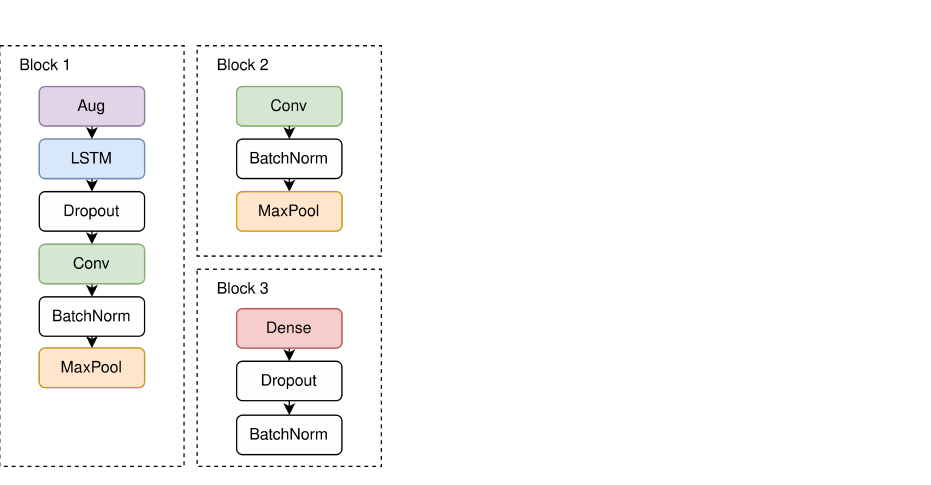
Figure 5. A detailed view of the three different blocks of layers used in our architecture.